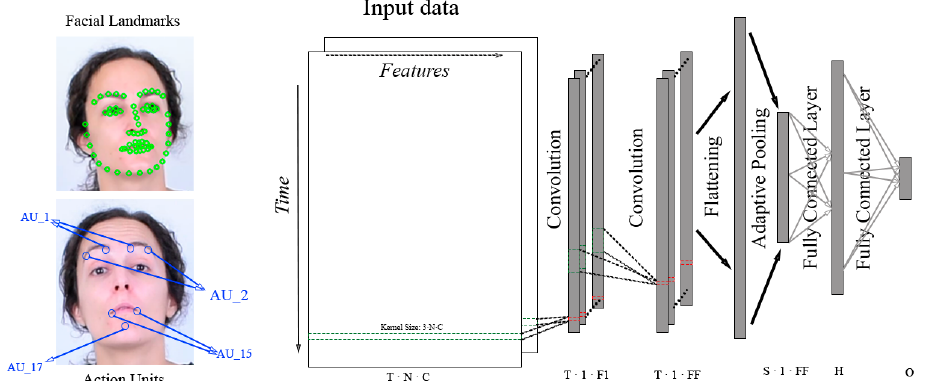
Figure 7. Overview of custom CNN architecture. The input data, whether facial landmarks or action units, is arranged in a matrix of shape T ( temporal _ length ) × N ( number _ of _ features ) × C ( dimensionality _ of _ features ) . This data is processed using F 1 convolutional filters of shape 3 × N × C to obtain F 1 feature vectors of shape T × 1. Then, extra convolutional blocks with different number of filters can be added resulting in a final set of FF feature vectors with shape T × 1. After that, these feature vectors are flattened and an adaptive pooling reduces their temporal dimension to S , obtaining a set of feature vectors with shape S × 1 × FF . Finally, those vectors are processed using two fully connected layers with a hidden space of H neurons resulting in O output